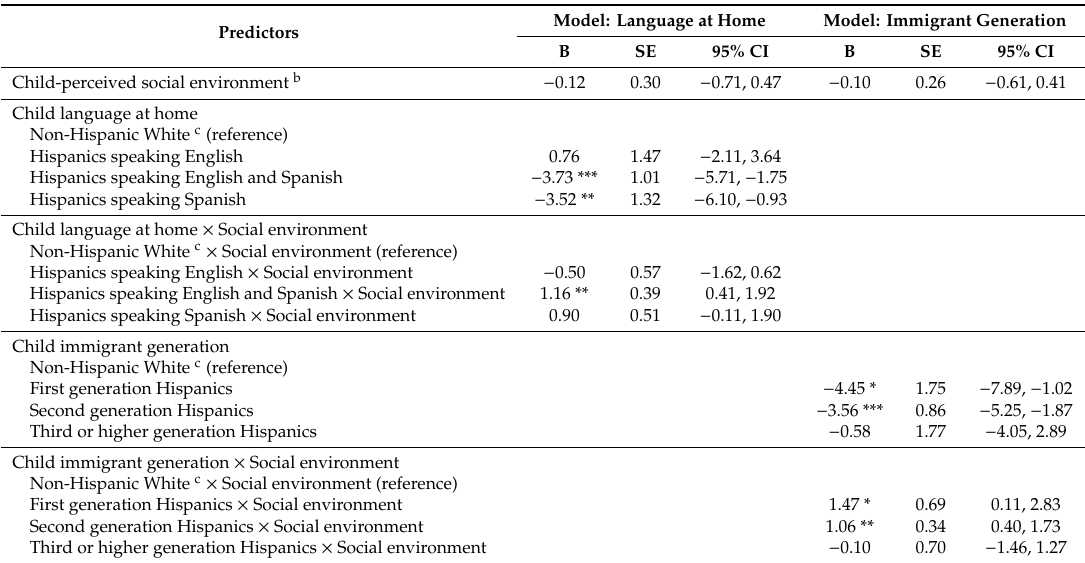
Table 5. Results of multilevel modeling assessing associations between cultural factors and physical activity (times per week) after multiple imputation, n = 3463 a . Model: Language at Home Model: Immigrant Generation Predictors B SE 95% CI B SE 95% CI Child-perceived social environment b − 0.12 0.30 − 0.71, 0.47 − 0.10 0.26 − 0.61,